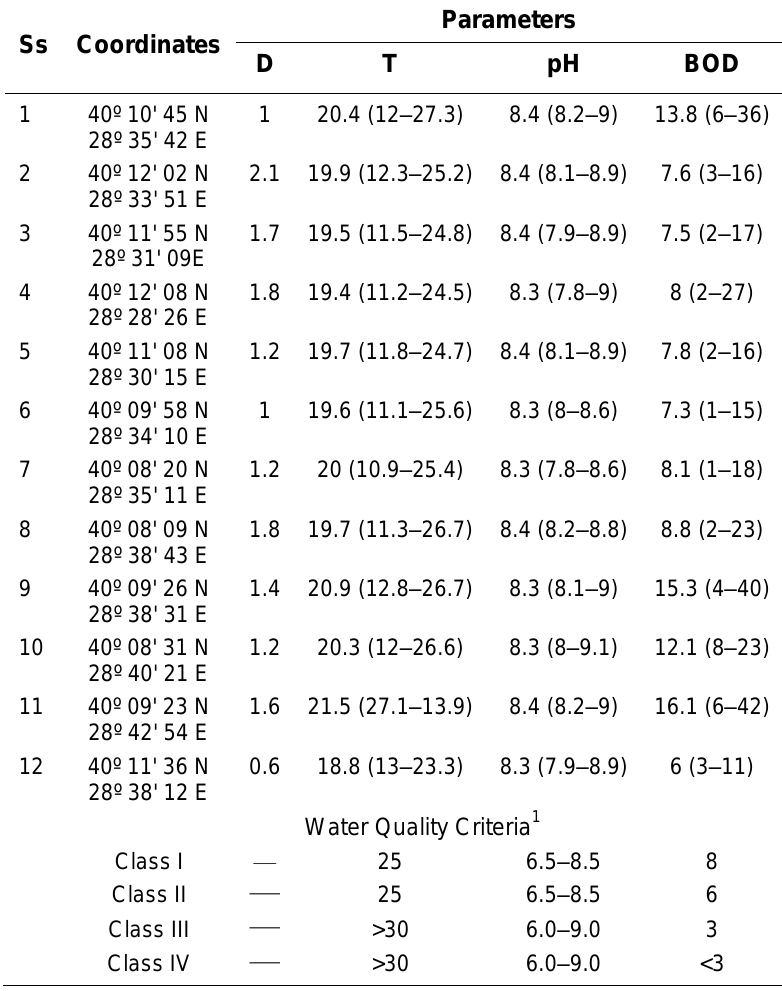
Sampling Station Coordinates, Median Basic Limnological Parameters*